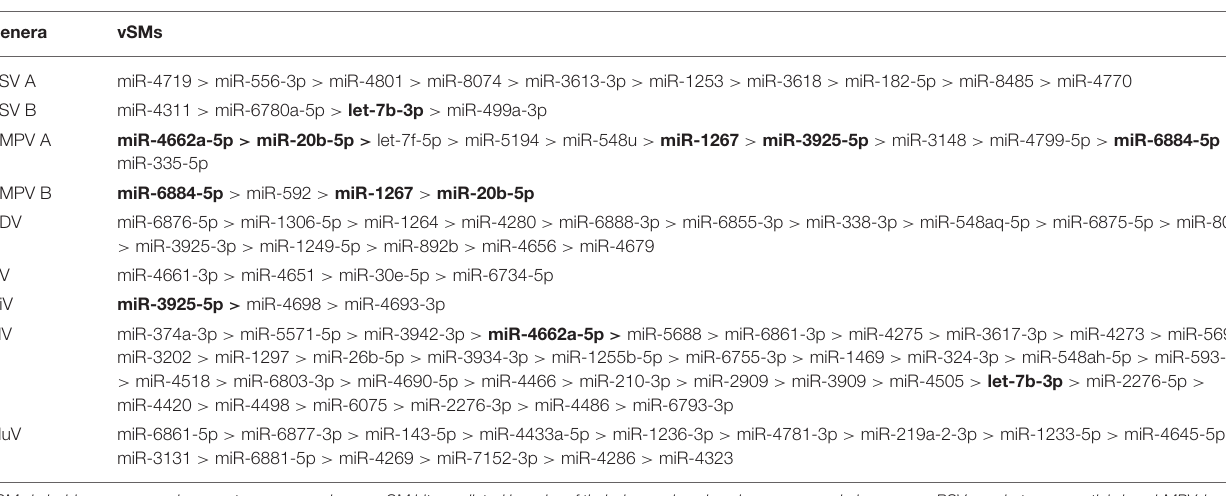
TABLE 2 | vSMs in Paramyxovirus genomes. Genera